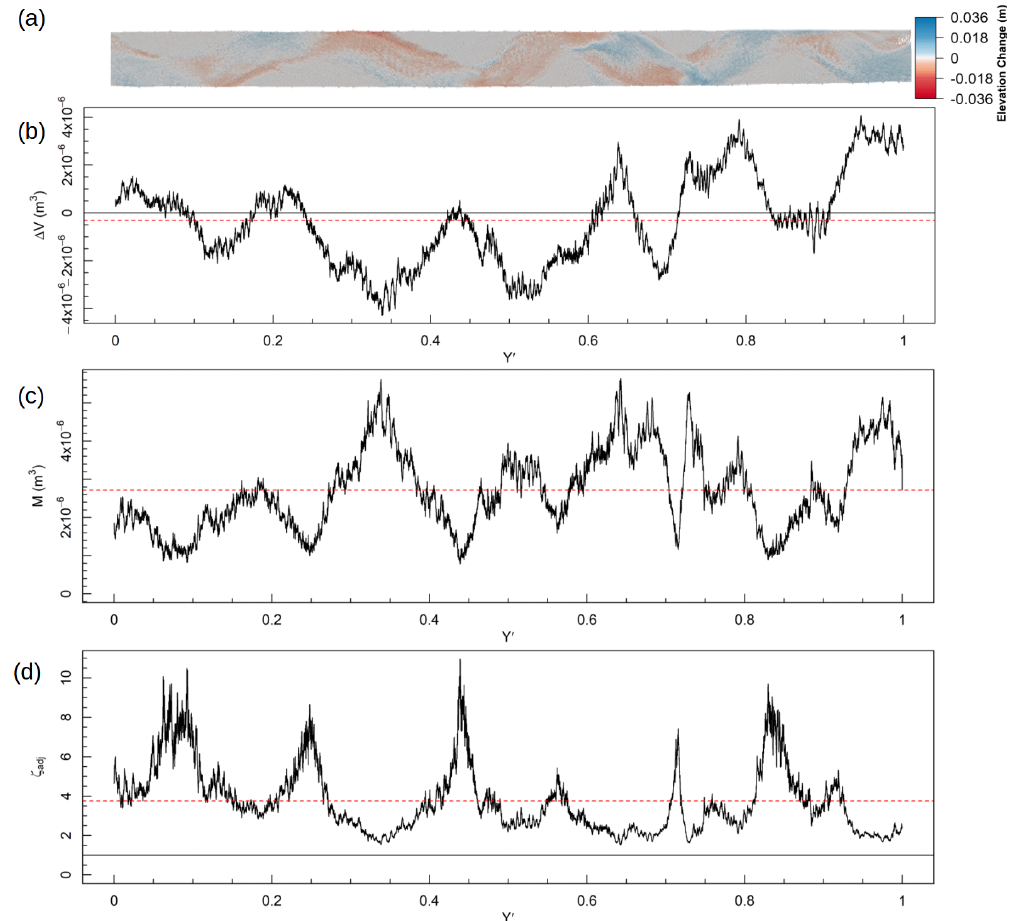
Figure 10. Example calculation of ζ for T = 480–600min in the fixed-bank experiment. See Fig. 8 for explanation.